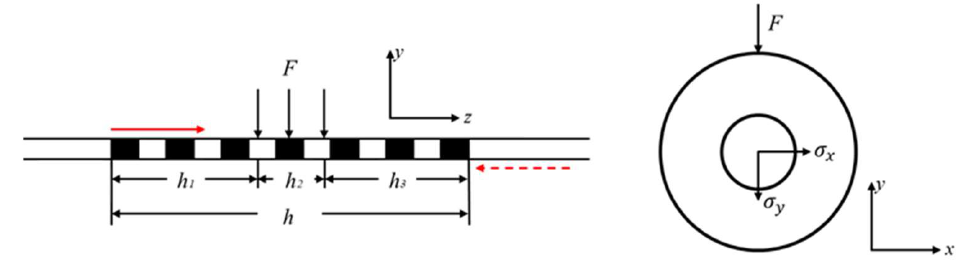
Figure 2. Schematic diagram of lateral stress: axial and cross-section of the grating.